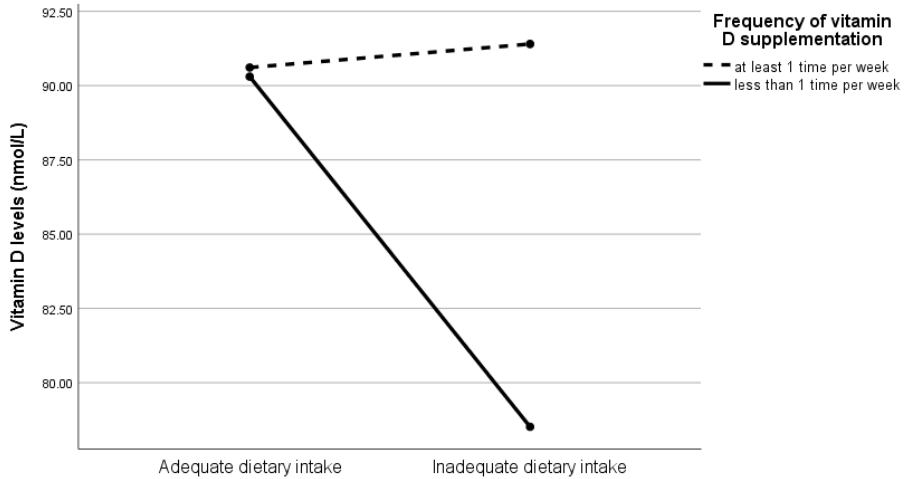
Figure 1. Serum 25(OH)D concentrations by status of dietary patterns and vitamin D supplementa- tion frequency. 25(OH)D, 25-hydroxyvitamin D.